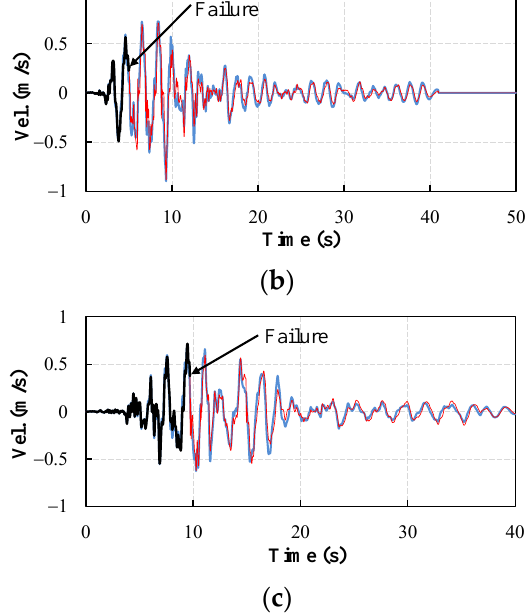
Figure 9. Velocities of the 1st floor under the ground motions at a 1 ‱ PE in one year: ( a ) El Centro; ( b ) Kobe; ( c ) Northridge.